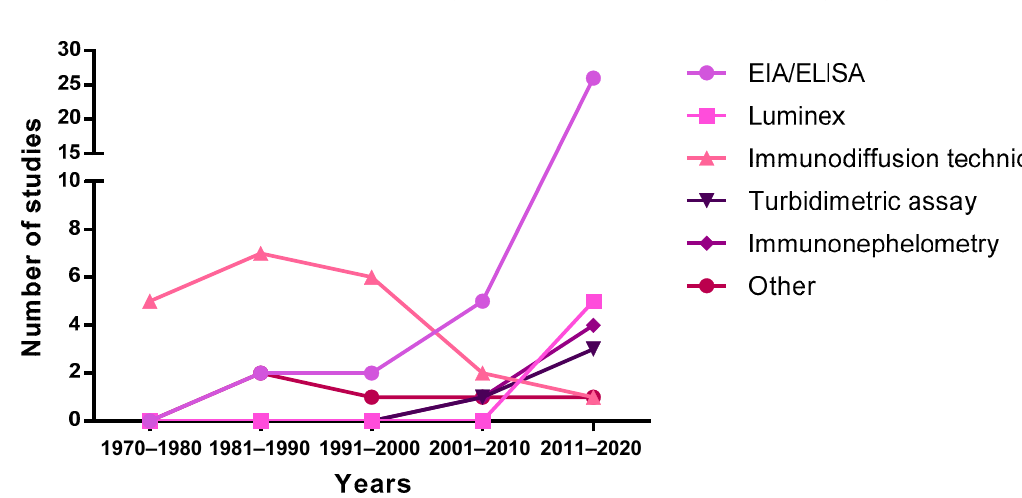
Figure 4. Evolution of the techniques used to measure immunoglobulin levels over the years. EIA, enzyme immunoassay; ELISA, enzyme-linked immunosorbent assay.